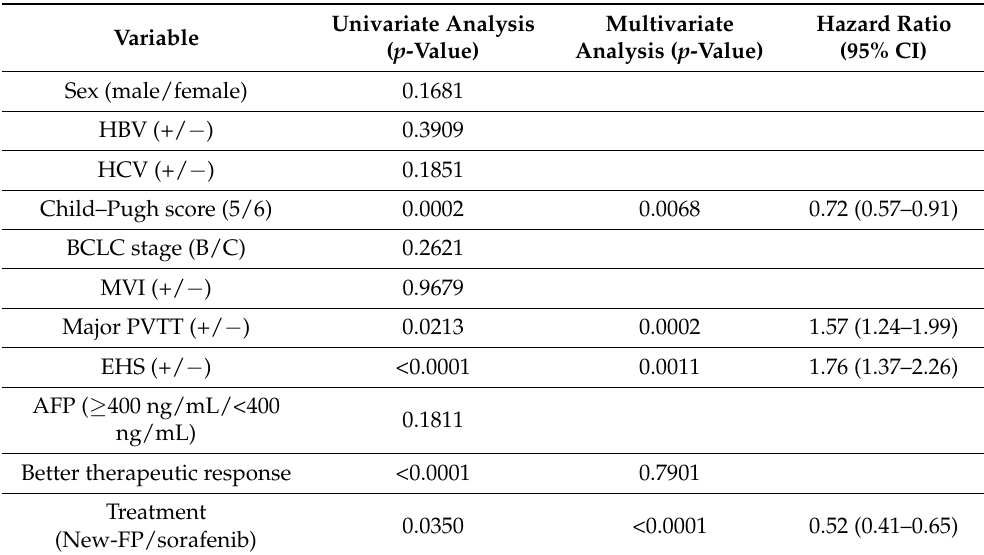
Table 2. Univariate and multivariate analyses for evaluating factors associated with overall